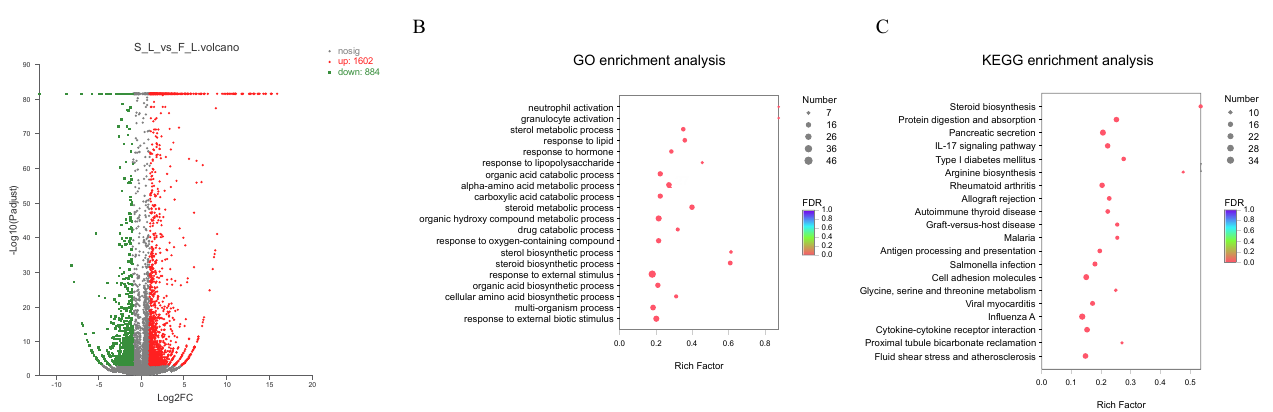
Figure 4. Differentially-expressed-gene screening and enrichment analysis: ( A ) volcano map of dif- ferentially expressed genes in livers; ( B ) GO enrichment; ( C ) KEGG-pathway enrichment of DEGs in livers.